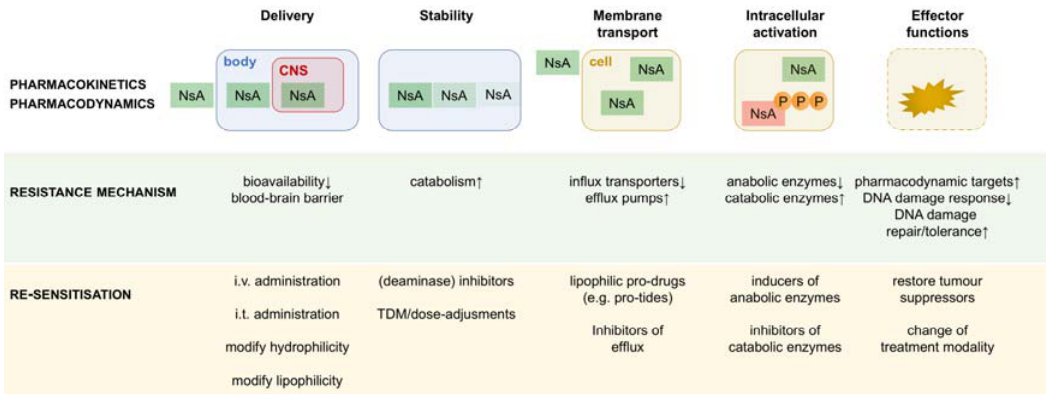
Figure 2. Schematic representation of the levels of resistance to nucleobase/nucleoside analogues. Resistance to nucleobase/nucleoside analogues can occur at the pharmacokinetic levels of delivery (e.g., due to the blood ‐ brain barrier), stability (e.g., due to plasmatic catabolic activity), membrane transport (e.g., due to down ‐ regulation of influx transporters), and intracellular activation (due to an imbalance in anabolic and catabolic enzymes). Further downstream, pharmacodynamic resistance can occur (e.g., due to overexpression of drug targets). Drug efficacy critically depends on the underlying tumour biology that determines the general susceptibility to cytotoxicity (for details, see text). Examples for re ‐ sensitisation strategies are given. NsA, nucleoside analogue; TDM, therapeutic drug monitoring; CNS, central nervous system.